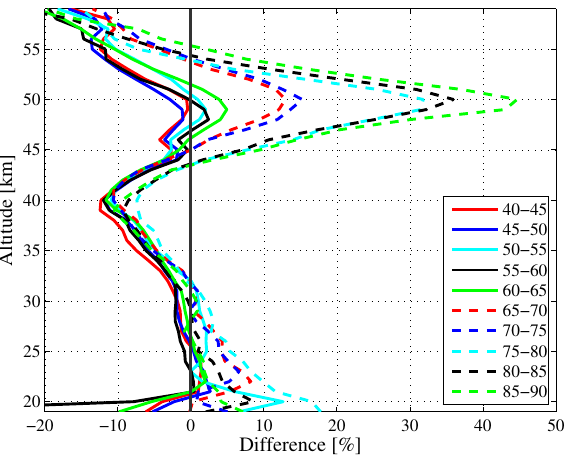
Figure 8. Median relative differences of GBL ozone profiles against GOMOS nighttime occultations for different solar zenith